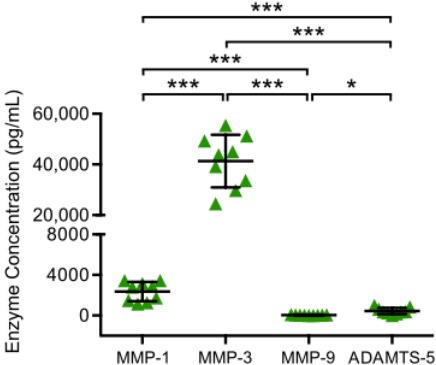
Figure 2. MMP and ADAMTS production of chondrocyte monocultures are displayed. Chondrocytes harvested from tibial plateau of patients with advanced knee OA were isolated and chondrocytes monocultures were incubated for 48 h at 37 °C. Then, enzyme concentrations in culture supernatants were analyzed performing enzyme linked immunosorbent assays. Mean and standard deviation of enzyme concentrations of MMP-1 / -3 / -9 and ADAMTS-5 are plotted ( n = 9). Significant di ff erences are indicated by asterisks: * p < 0.05; *** p < 0.001.